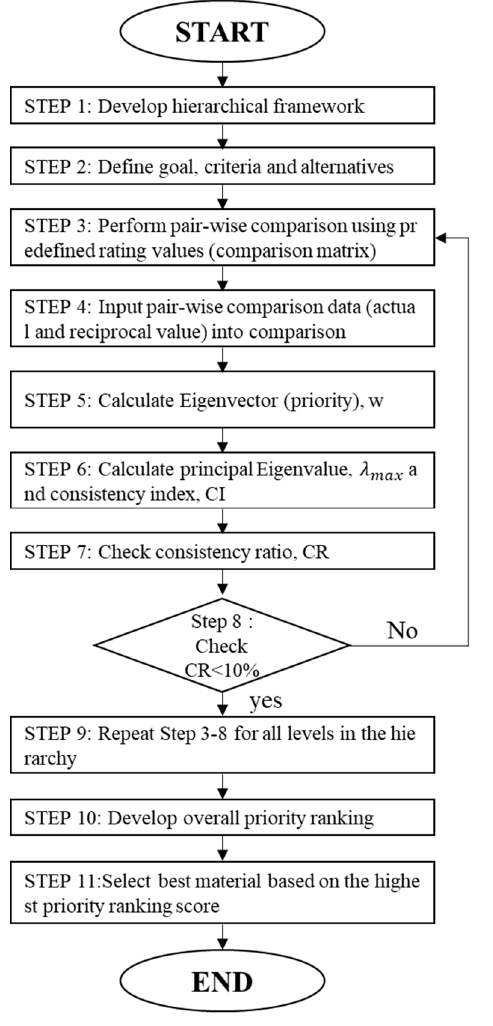
Figure 2 . Analytic hierarchy process (AHP) methodology for material selection. Figure 2. Analytic hierarchy process (AHP) methodology for material selection.